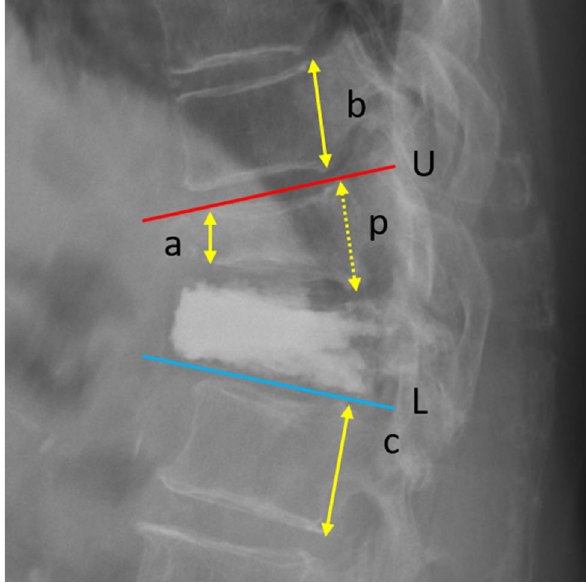
Figure 2. Measurement of the anterior body height and focal kyphotic angle. a, anterior body height of the VCF; b, posterior vertebral height of the adjacent cranial vertebra; c, posterior vertebral height of the adjacent caudal vertebra; p, estimate of the posterior body height of the VCF (average of b and c). The anterior body height ratio is a/p; U, the line parallel to the upper endplate of the cranial vertebra (red line); L, the line parallel to the lower endplate of the caudal vertebra (blue line). The focal kyphotic angle is the intersecting angle of U and